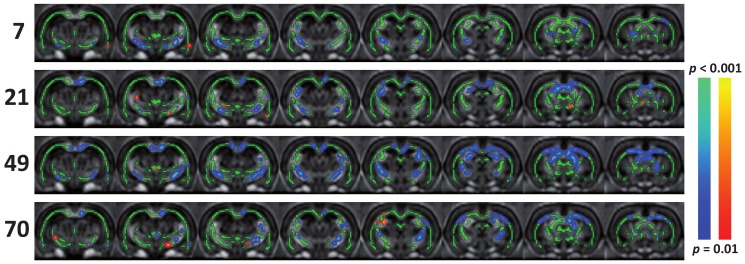
Tract-based spatial statistics results.Tract-Based Spatial Statistics output, illustrating significant differences in white matter fractional anisotropy (FA) values in epileptic brain as compared to controls (blue: reduced; red: increased. Color codes represent p<0.01 – p<0.001; false discovery rate corrected), overlaid on average FA maps of adjacent coronal rat brain slices. White matter skeleton is shown in green. Time points (days) are shown on the left.